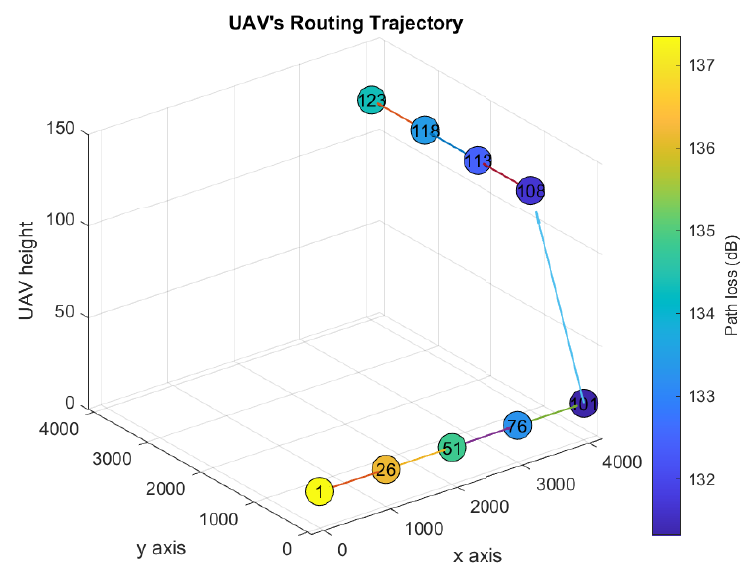
Figure 9. UAV’s trajectory design over the path loss map using Algorithm 1 (Scenario 2).